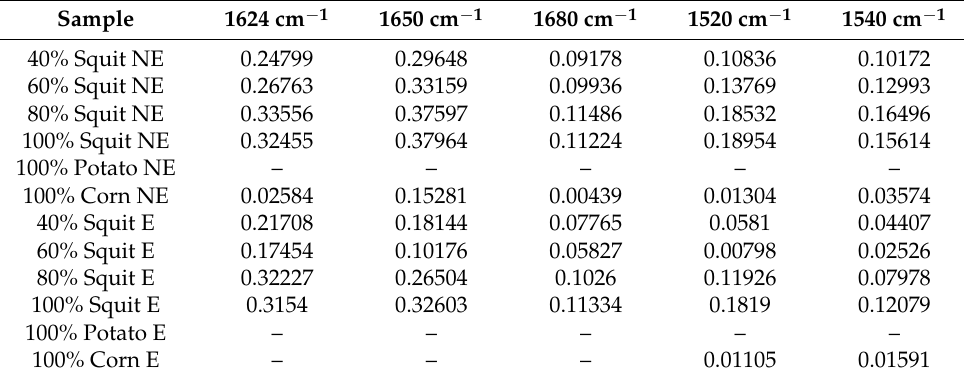
Table 3. Absorbances after the deconvolution of the amide I region of the different squid–potato– corn